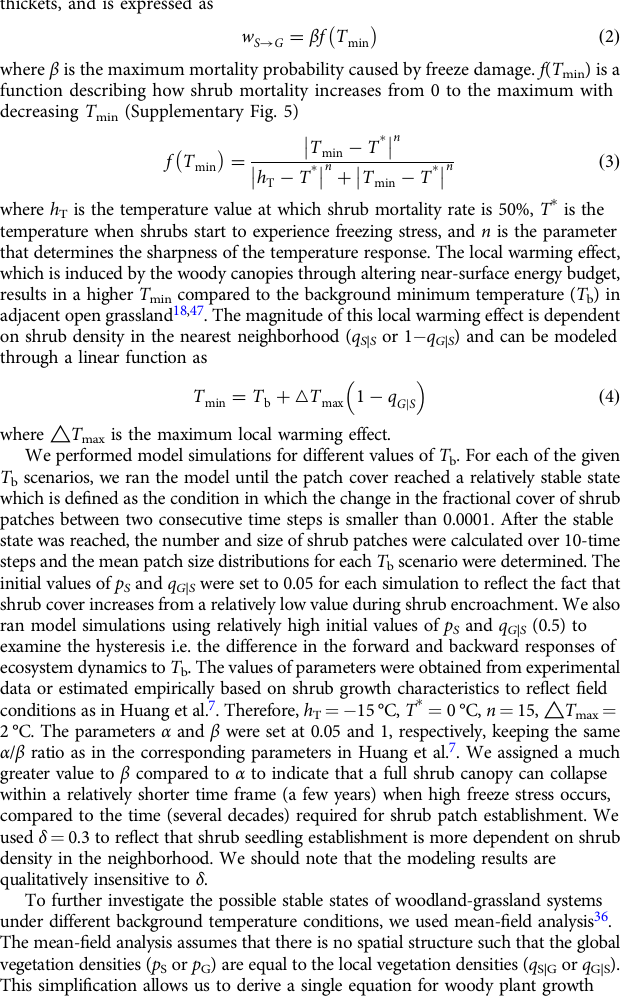
Supplementary Table 2. We then fi tted a power law using the NonlinearModelFit function in Mathematica 12.0 (Wolfram Research, USA) to the inverse cumulative distribution of shrub patch sizes, de fi ned as P ( A ≥ a ), the probability of a cluster area A being greater than or equal to a given value a 35 . This approach has been demonstrated to provide more robust estimates of distribution parameters than other traditional approaches including fi tting frequency distribution 25,46